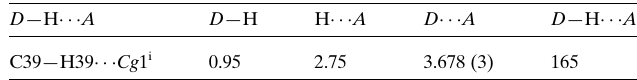
Table 1 Hydrogen-bond geometry (A˚ , (cid:3) ).